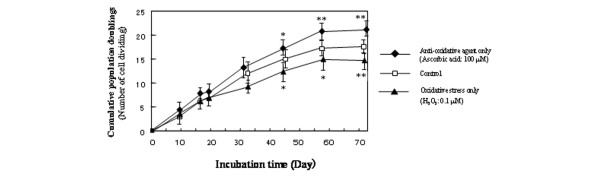
Chondrocyte replicative capacity under the various oxidative conditions. At each subculture (initial subculture at the start of the experiment: 5 × 104 cells/dish, primary culture), the total number of cells in the dish was determined, and the cells (1 × 105 cells/dish) were placed in a new dish. The number of cells that had attached 6 hours after seeding was determined. The increase in cumulative population doublings (number of cell divisions) at each subculture (n = 4 per treatment group) was calculated based on the number of cells attached and the cell yield at the time of the next subcultivation. Cell cultures were considered to have achieved their proliferative limit (senescence) when they did not exceed a twofold increase in 4 weeks. Values are expressed as mean ± standard deviation of four donors. *P < 0.05 and **P < 0.01, versus control group at each incubation time.